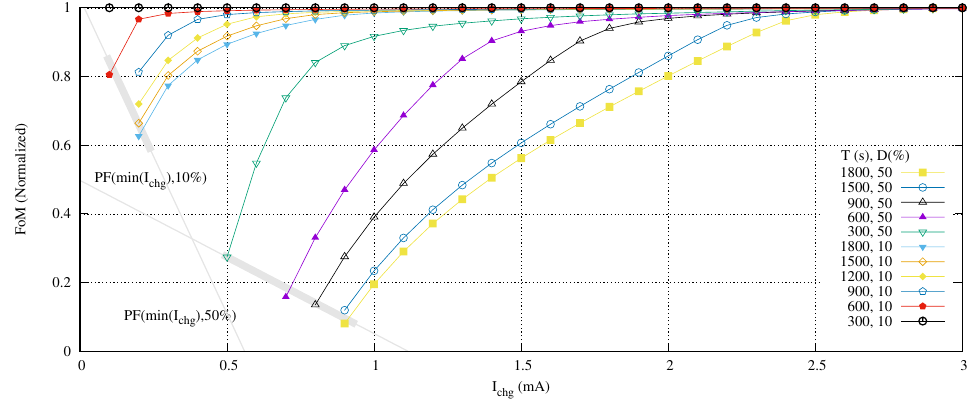
Figure 12. Normalized FoM for different duty cycles and T .